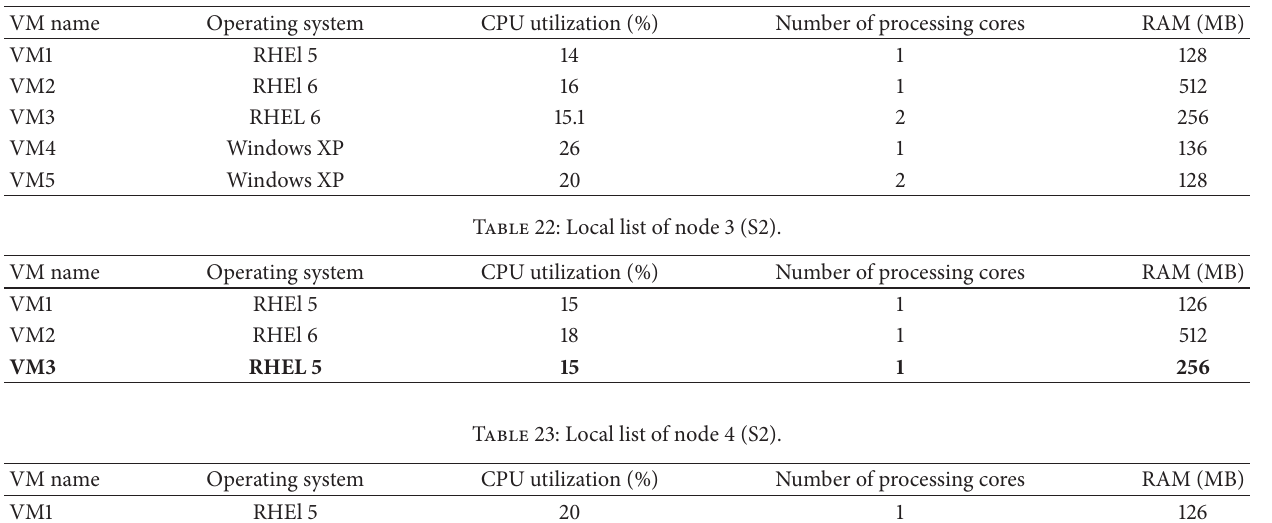
Table 21: Local list of node 1 (S2).